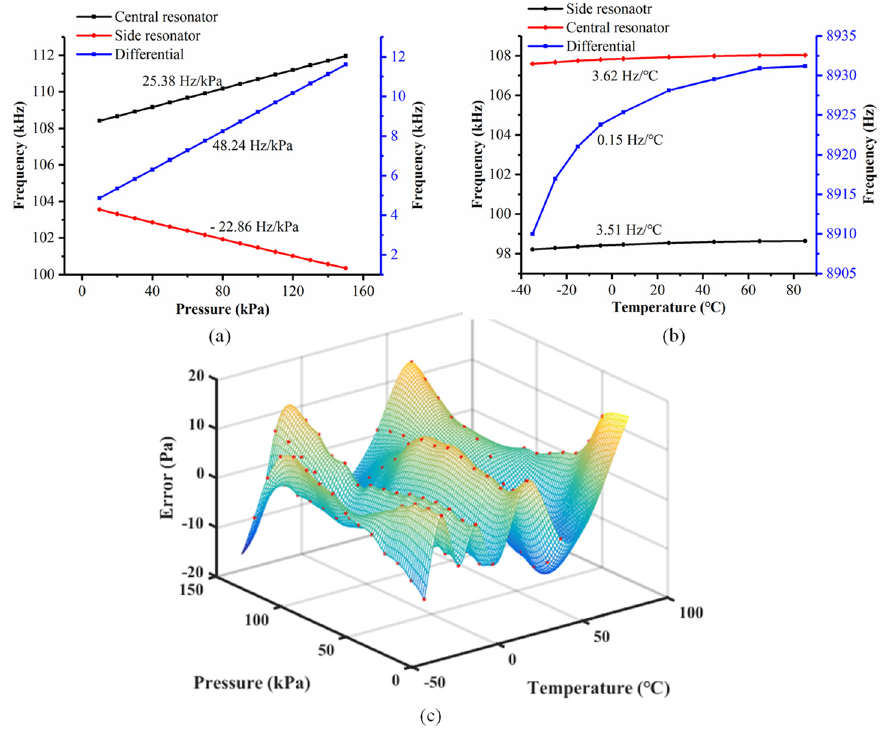
Figure 7. The pressure( a ) / temperature ( b ) responses of the proposed resonant pressure sensor based on comb drive with compensated errors ( c ).